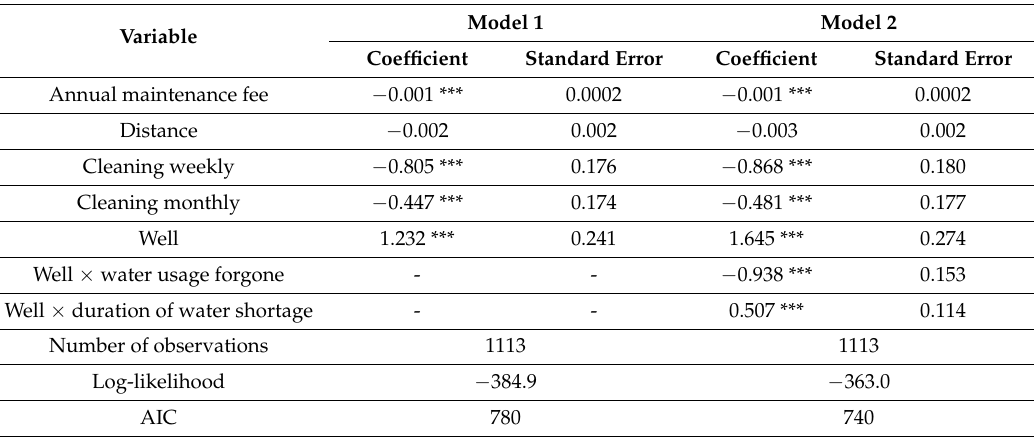
Table 4. Alternative specific conditional logit estimation.